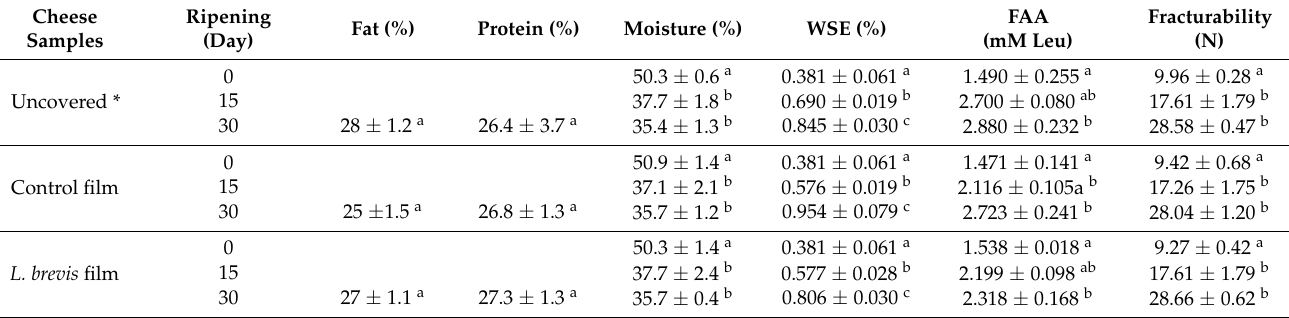
Table 2. Evaluation of moisture content, fat, protein, water soluble extract (WSE), free amino acids (FAA), and fracturability (breaking force) of cheddar-type cheese without film (uncovered), covered with control films (without LAB), and covered with L. brevis SJC120 films. Values are the mean ± SEM ( n =